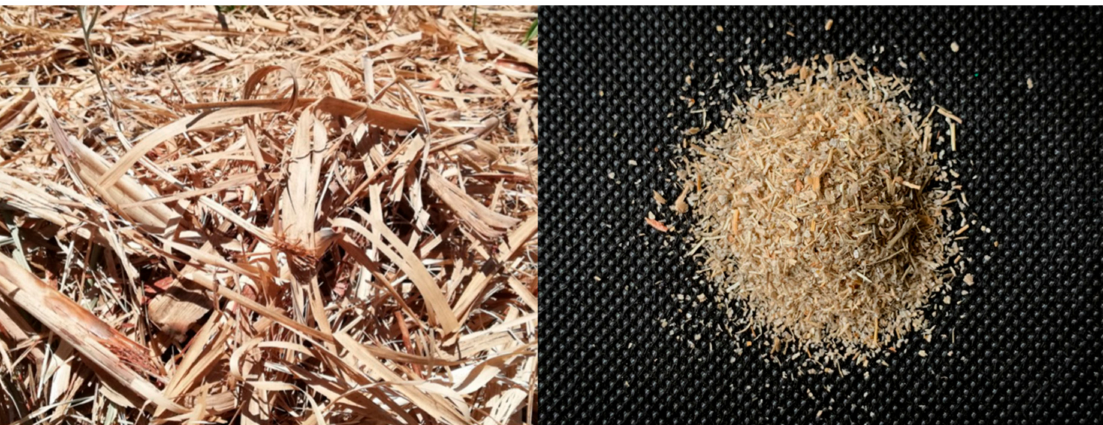
Figure 1. Sugarcane straw.